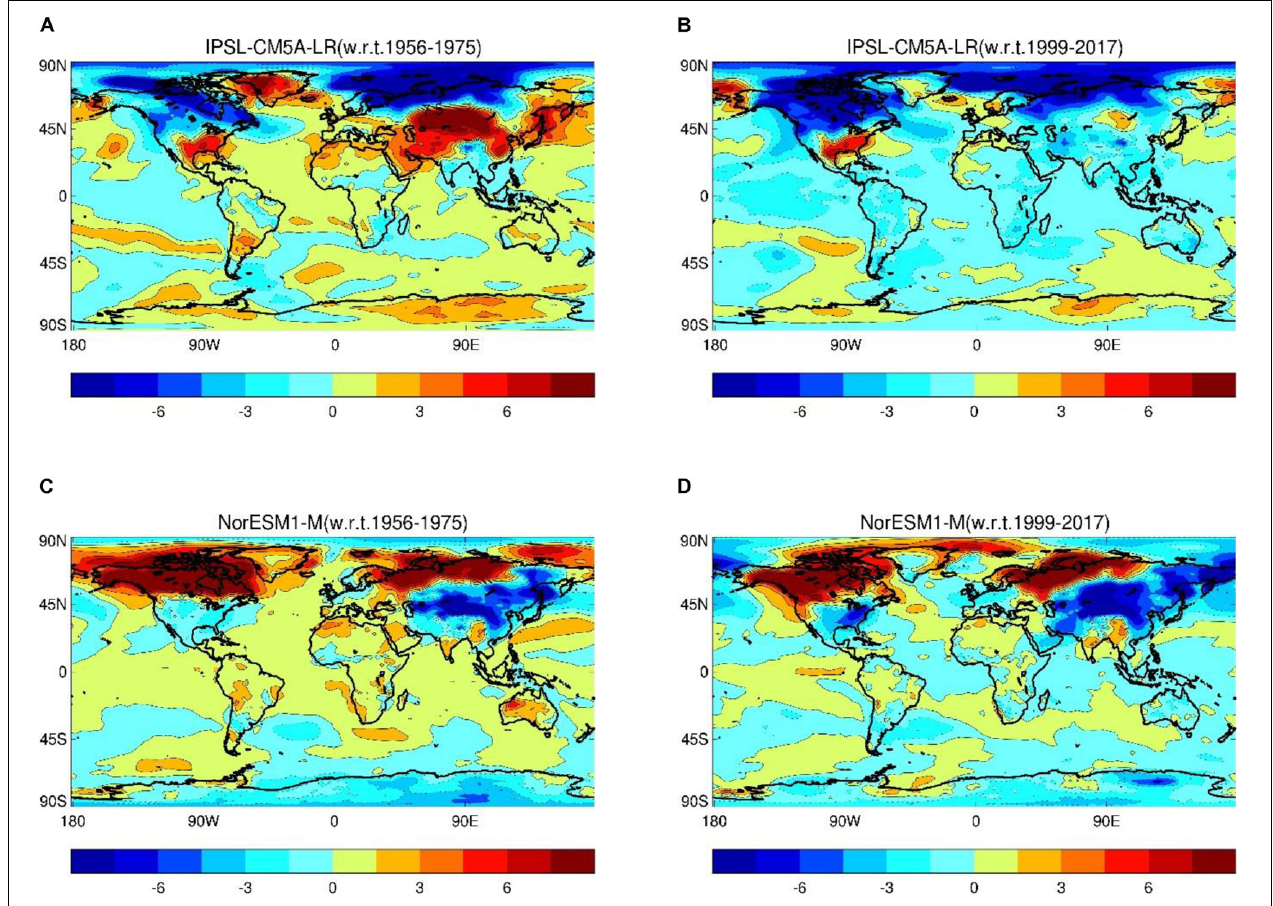
FIGURE 5 | Mean surface temperature (DJF): 1976–1996 minus 1956–1975 (Left); 1976–1996 minus 1999–2017 (Right) for two arbitrarily chosen CMIP5 models, IPSL-CM5A-LR (top) and NorESM1-M